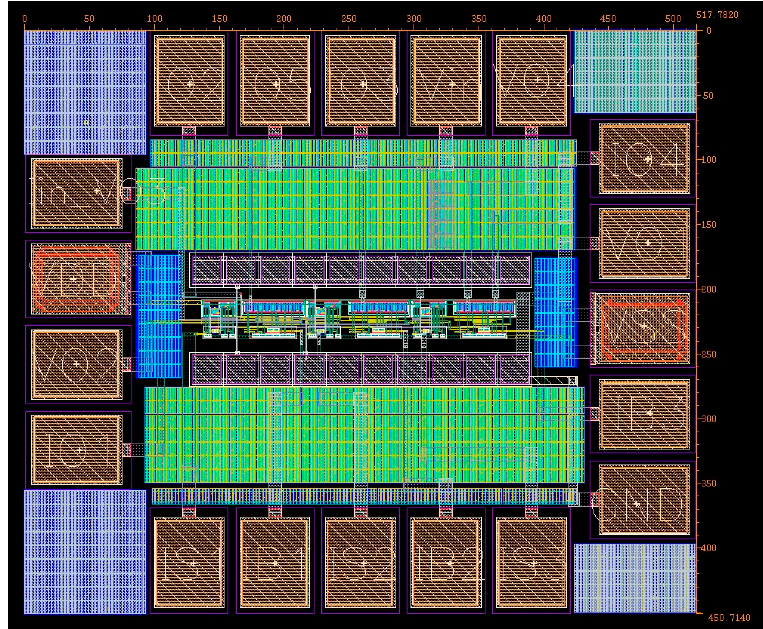
Figure 13. The layout of the proposed mixed-mode biquadratic filter chip. Appl. Sci. 2017 , 7 , 244